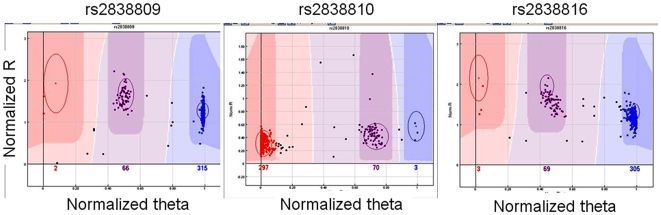
Result of genotype cluster algorithm from BeadStudio.The three plots show the normalized intensities in polar coordinate and the cluster definition from BeadStudio for NECS subjects. The clear separation suggests that the genotype calls are robust.